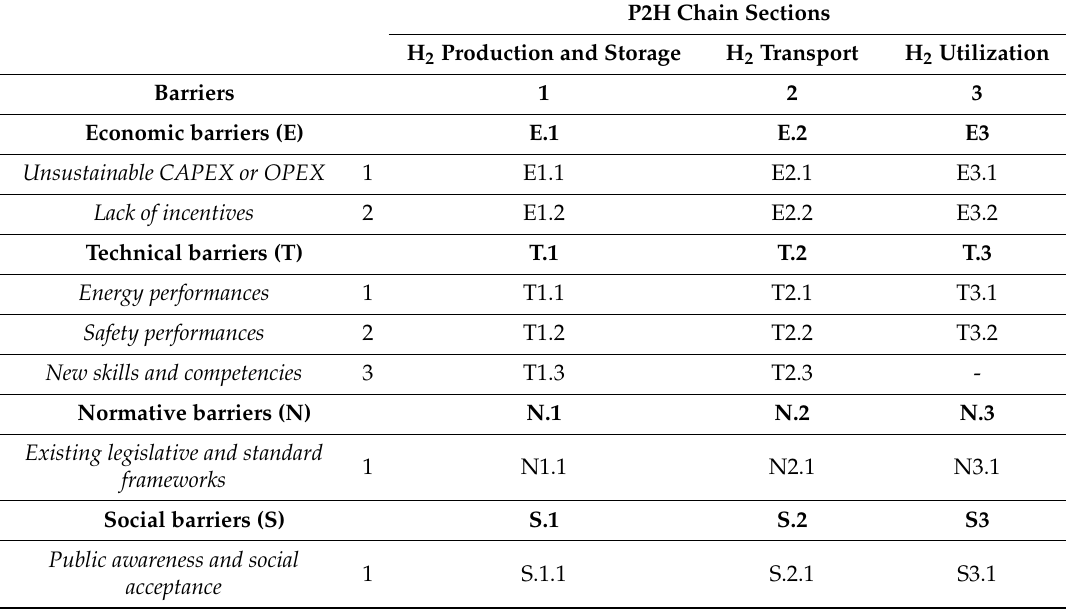
Table 5. Classification of the main barriers to P2G development in